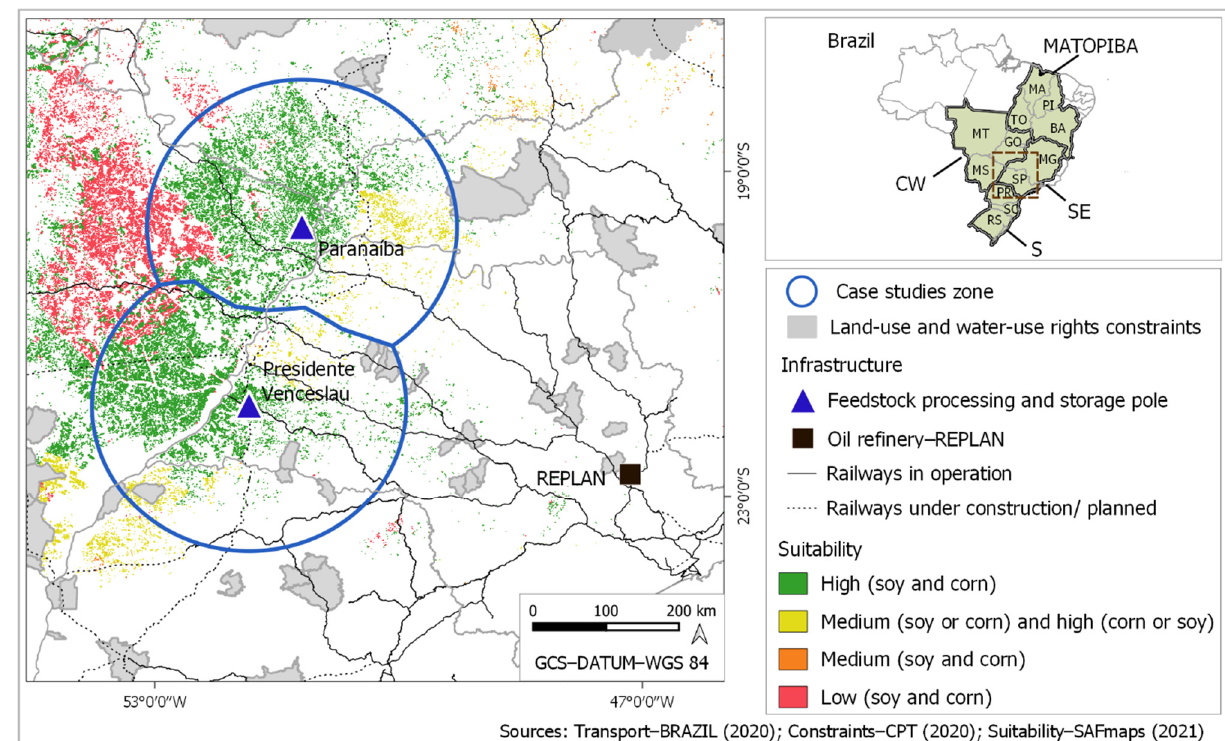
Figure 2. Location of the case studies of soy production (the blue triangles indicate the poles), the available and predicted infrastructure, areas with land-use and water-use rights constraints, and the estimated suitability of soybean and corn in pasturelands (cluster of 100 ha).